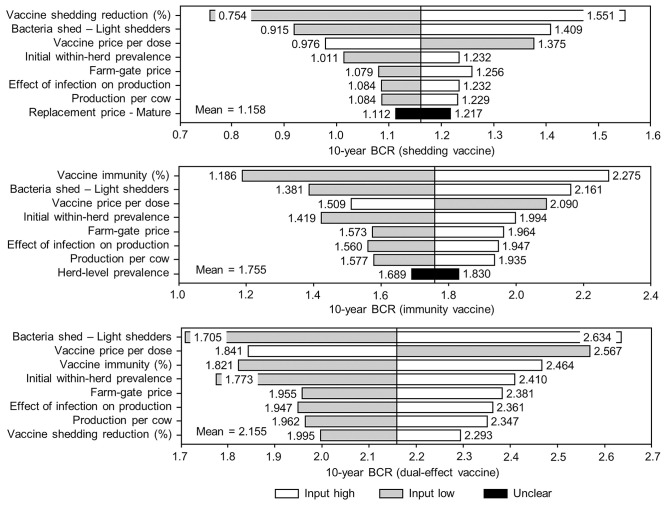
Sensitivity of 10-year benefit-cost ratios (BCRs) associated with various JD (paratuberculosis) vaccine types in average Canadian dairy herds to a range of input variables. Assumes initial mean values of 10% for within-herd Mycobacterium avium subsp. paratuberculosis (MAP) infection prevalence, 50% for herd-level prevalence, and 50% for vaccine efficacies. The color of the sensitivity bars indicates the direction of the relationship between the variable and 10-year BCR (grey indicates the effect of variable values below their mean value, white indicates the effect of values above their mean, and black indicates that the effect is unclear).